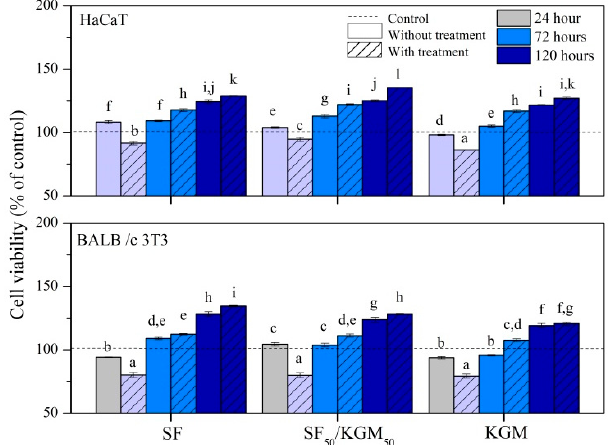
Figure 9. Cytotoxicity of beads to HaCaT and BALB/c 3 T3 cells. Mean ± SD ( n = 3), means with the same letter indicate that there is no significant difference ( p < 0.05) by the Tukey test.